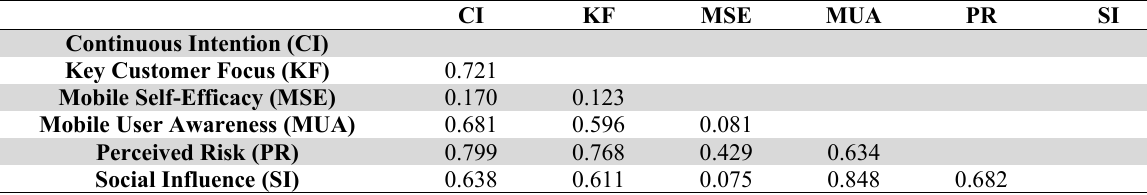
Continuous Intention (CI)